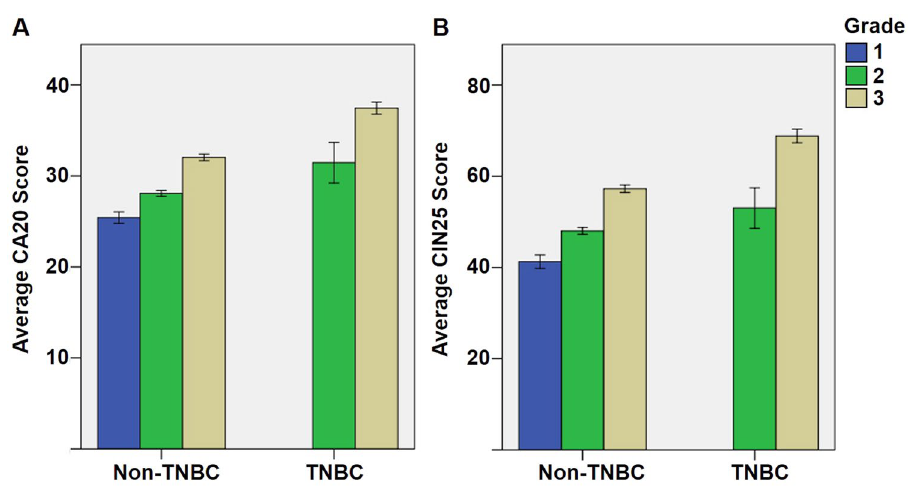
Figure 2. Grade-wise comparison of ( A ) average CA20 score and ( B ) average CIN25 score in non-TNBCs vs. TNBCs in the METABRIC dataset, which were significantly different at the p < 0.001 level in grade-matched comparisons. Error bars represent 95% confidence